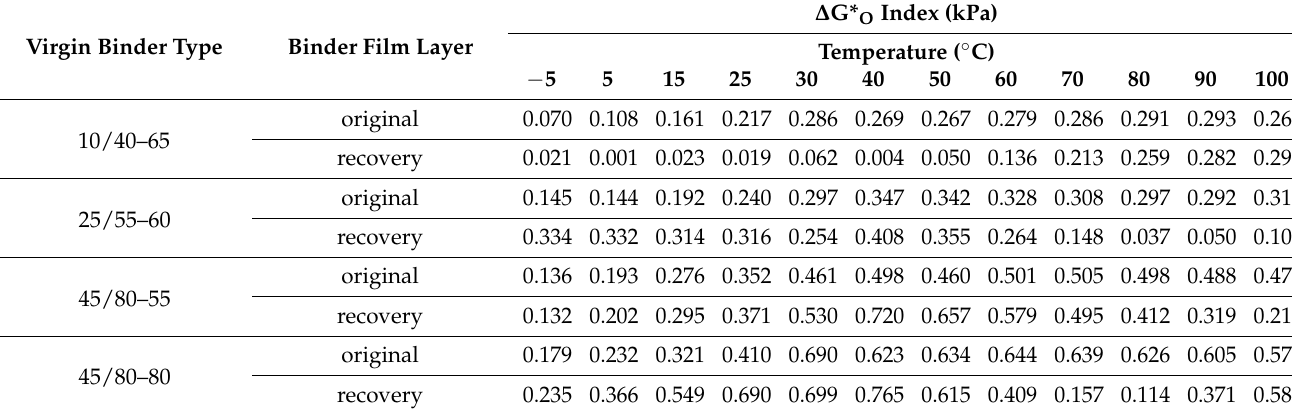
Table 3. ∆ G* O index for the original and after staged extraction recovered polymer-modified bitumens.